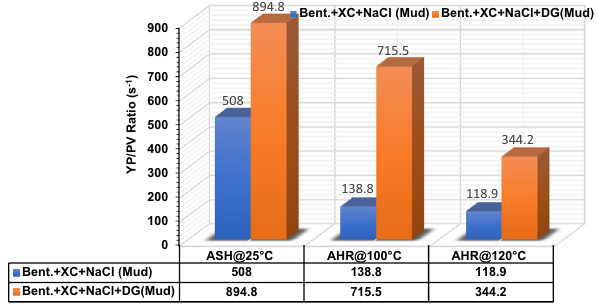
Fig. 13 Comparison of the YP/PV ratios of the drilling muds contain- ing a salt